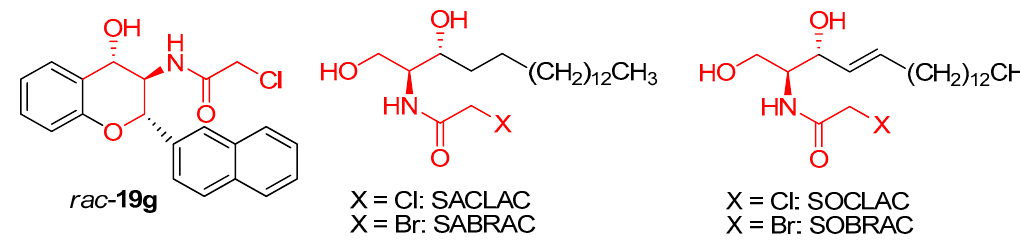
Figure 3. Structures of rac - 19g (antiproliferative activity) and irreversible acid ceramidase inhibitors. SACLAC and SABRAC were found to inhibit the growth of chemoresistant forms of prostate cancer [43] and to reduce the viability of acute myeloid leukemia cells with an EC 50 of approximately 3 μ M across 30 human cell lines [44].